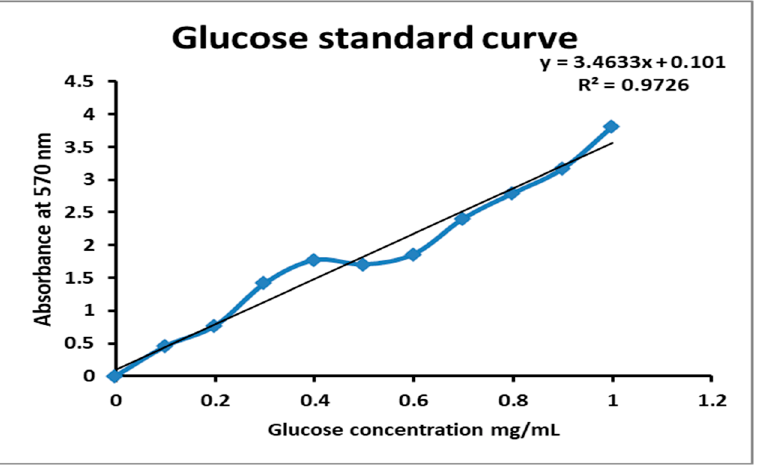
Figure 1. Glucose standard curve.